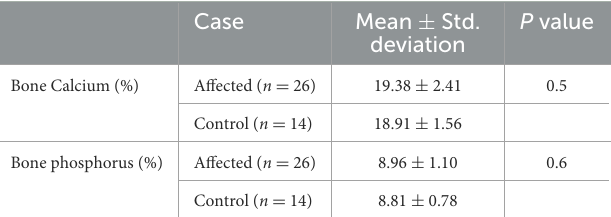
TABLE 3 Mean ± SD of the calcium and phosphorus percentage concentration in humeral samples from affected and control